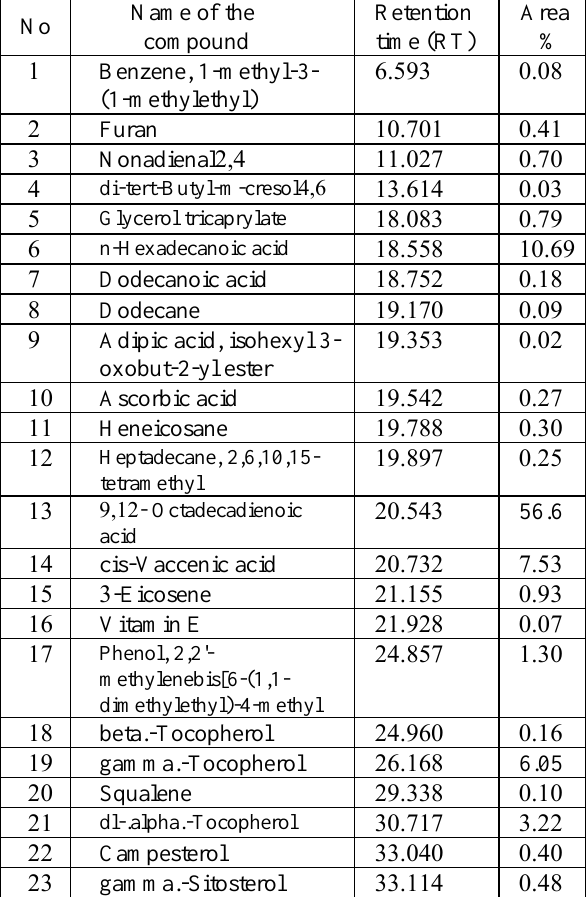
Table 1: The chemical compositions of wheat germ oil sample by using (GC)--mass